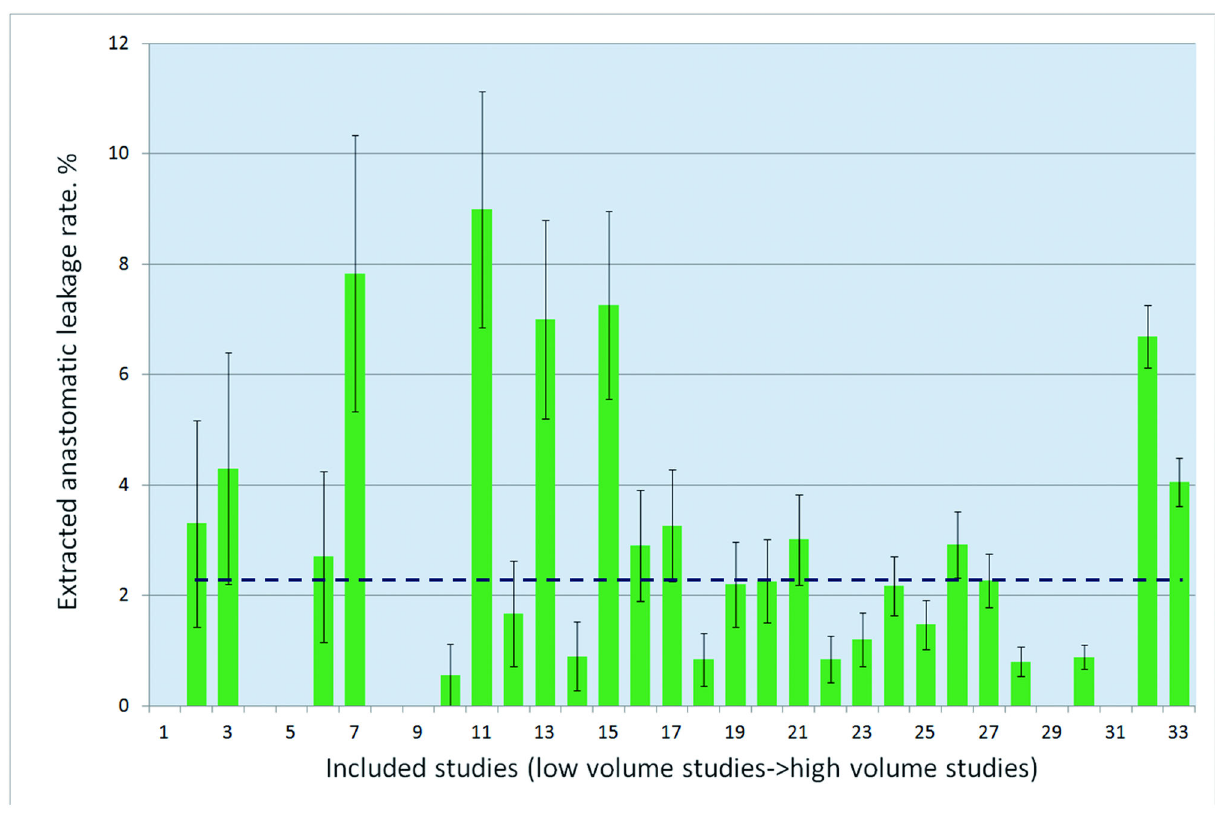
Figure 4. Extracted rates of Grade B leakage ranked by